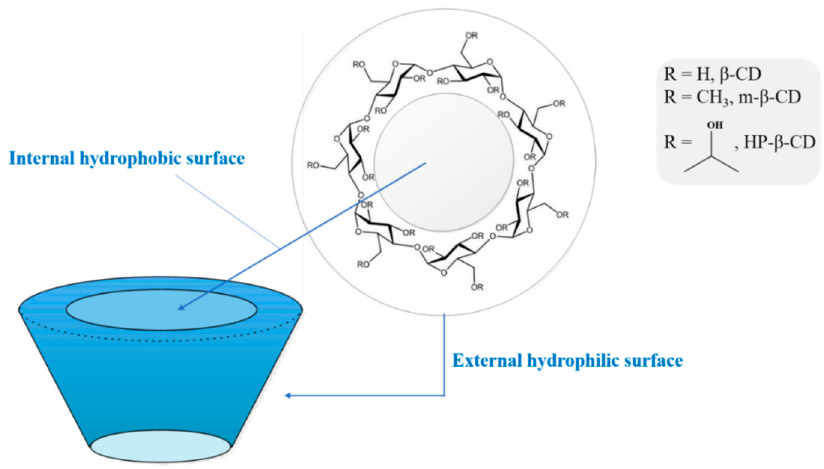
Figure 1. Cyclodextrin structures tested in this study. Assignments: m- β -CD, methyl β -cyclodextrin; HP- β -CD, hydroxypropyl β -cyclodextrin; β -CD, β -cyclodextrin.